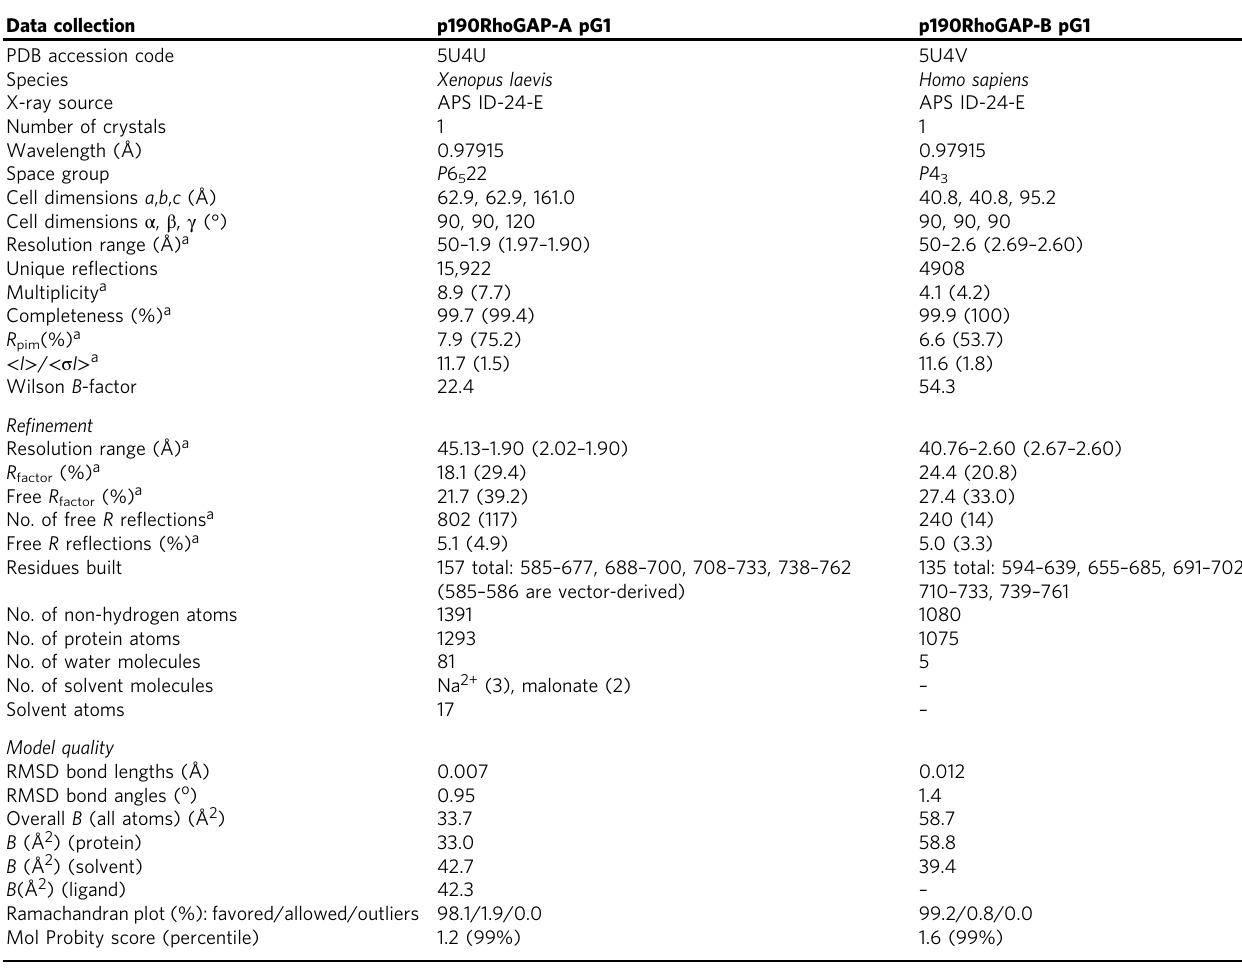
Table 1 Data collection and re fi nement